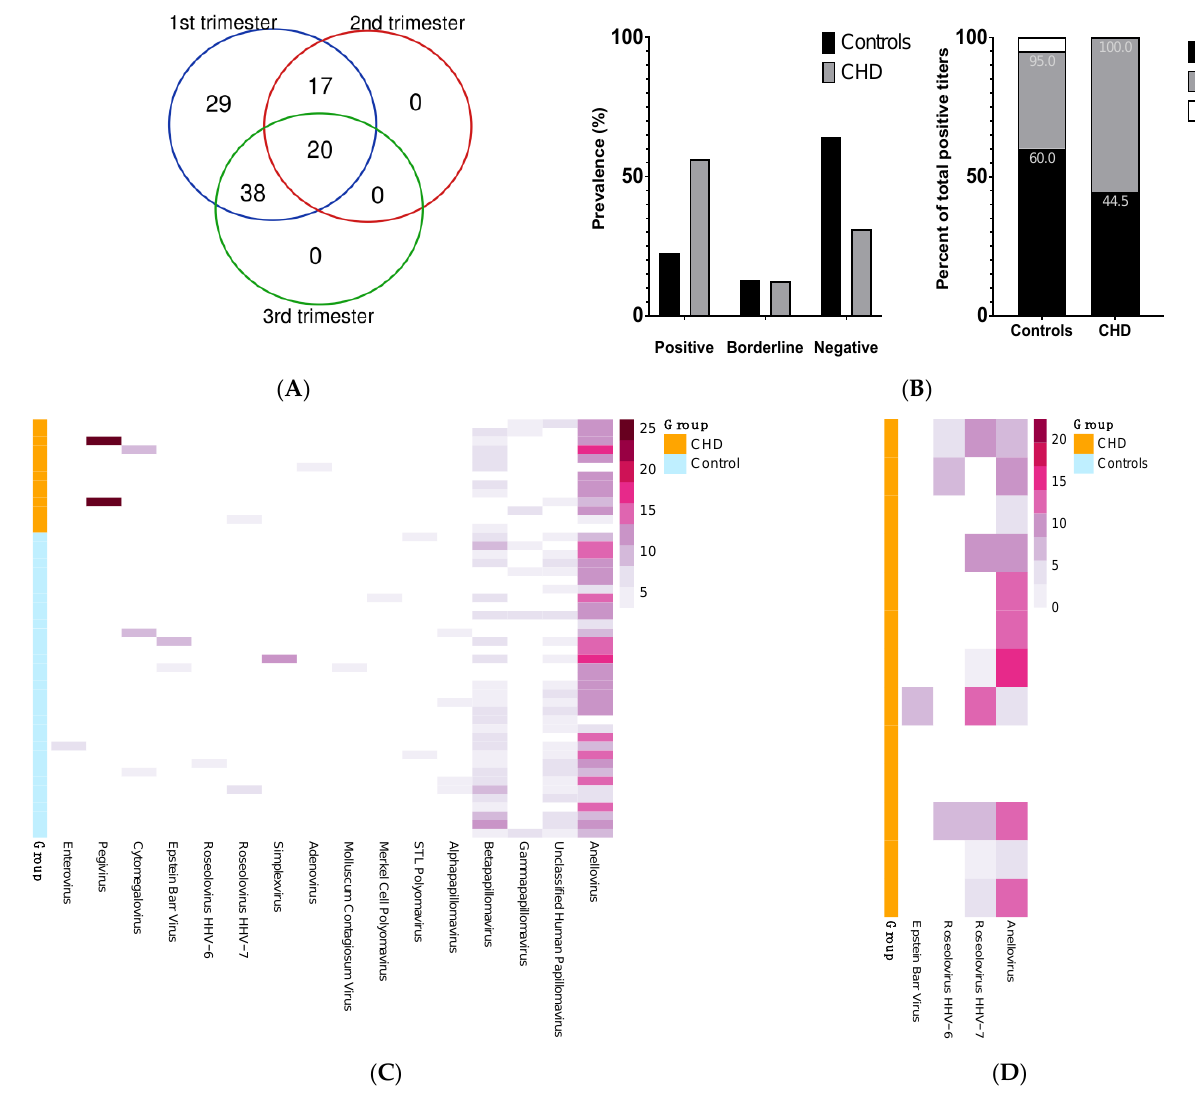
Figure 1. ( A ) Distribution of samples collected by trimester for all pregnancies (total = 104). ( B ) Prevalence of CVB serology calls among Control and CHD groups (top histogram) and proportion of IgG and IgM serology results among individuals identified as positive for CVB (bottom stacked bars). ( C ) Distribution of viruses detected by ViroCap among the pools of CHD-affected (CHD) and healthy controls (Controls) pregnancies. Each row represents a pooled sequencing library ( n = 4 or 5 plasma samples per pool). Plasma samples were collected at various times through pregnancy (weeks 5 – 41 of gestational age). Columns show virus detected (the gradient color of the bar correlates to the log2 normalized sequencing reads). ( D ) Distribution of viruses detected in the buffy coat by ViroCap in a subset of individuals. Each row represents individual library. Buffy coat samples were collected at 1st trimester visit. Columns show virus detected (the gradient color of the bar correlates to the log2 normalized sequencing reads).